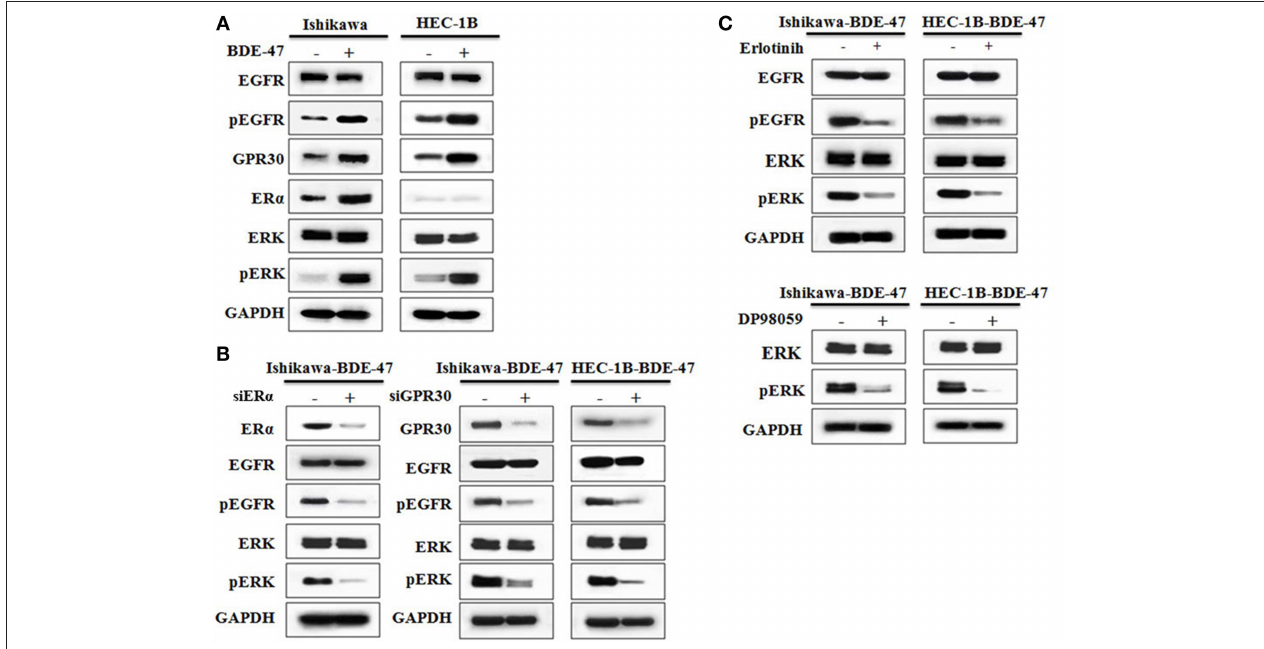
FIGURE 3 | Western blotting on protein expressions of ER α , GPR30, EGFR, pEGFR, ERK, and pERK. (A) Protein expression in Ishikawa and HEC-1B cells with or without exposure to 10 µ M BDE-47. (B) Protein expression in Ishikawa-BDE-47 and HEC-1B-BDE-47 cells treated with or without siER α , and siGPR30. (C) Expression of pEGFR and EGFR in Ishikawa-BDE-47 and HEC-1B-BDE-47 after pEGFR inhibitor (erlotinib) treatment (left). Expression of pERK and total ERK in Ishikawa-BDE-47 and HEC-1B-BDE-47 after pERK inhibitor (DP98059) treatment